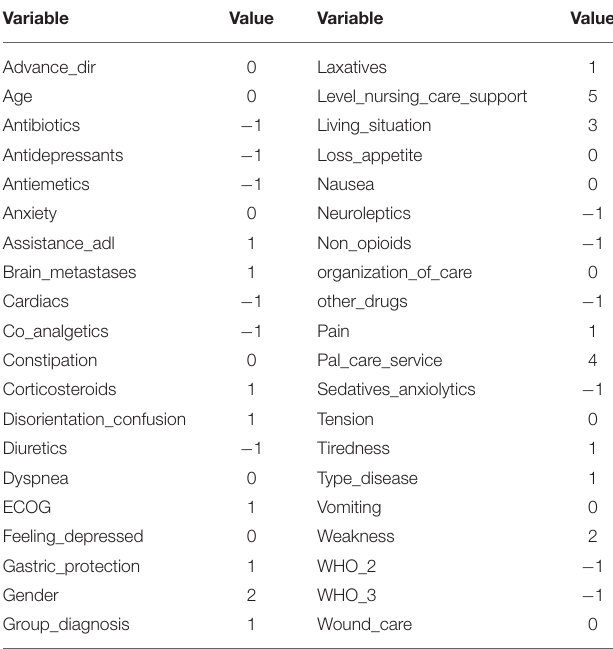
TABLE 3 | One example record from the data